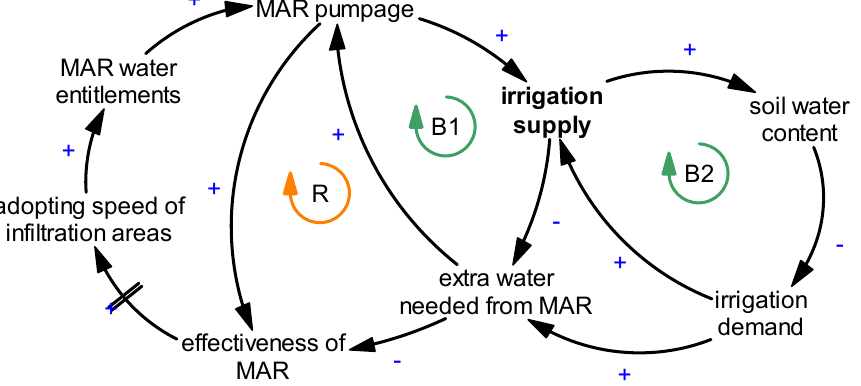
Figure 15. Causal loop diagram of the impact of MAR on irrigation supply.